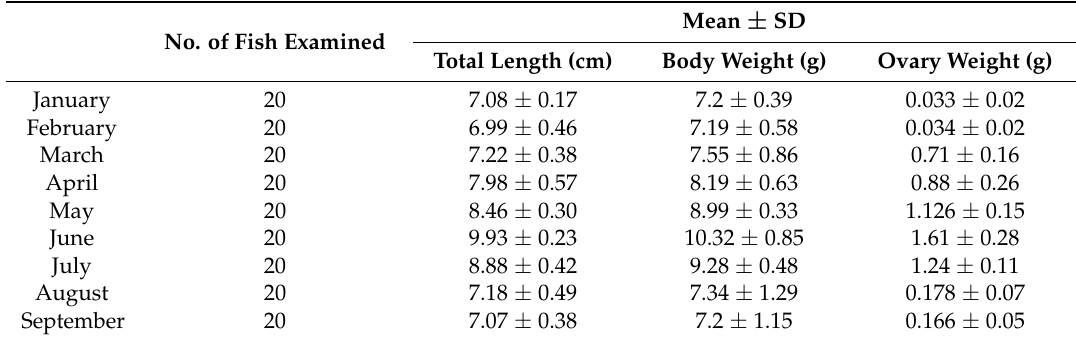
Table 2. Mean and standard deviation (±SD) of total length, body weight and ovary weight in female P. sophore in Jessore.